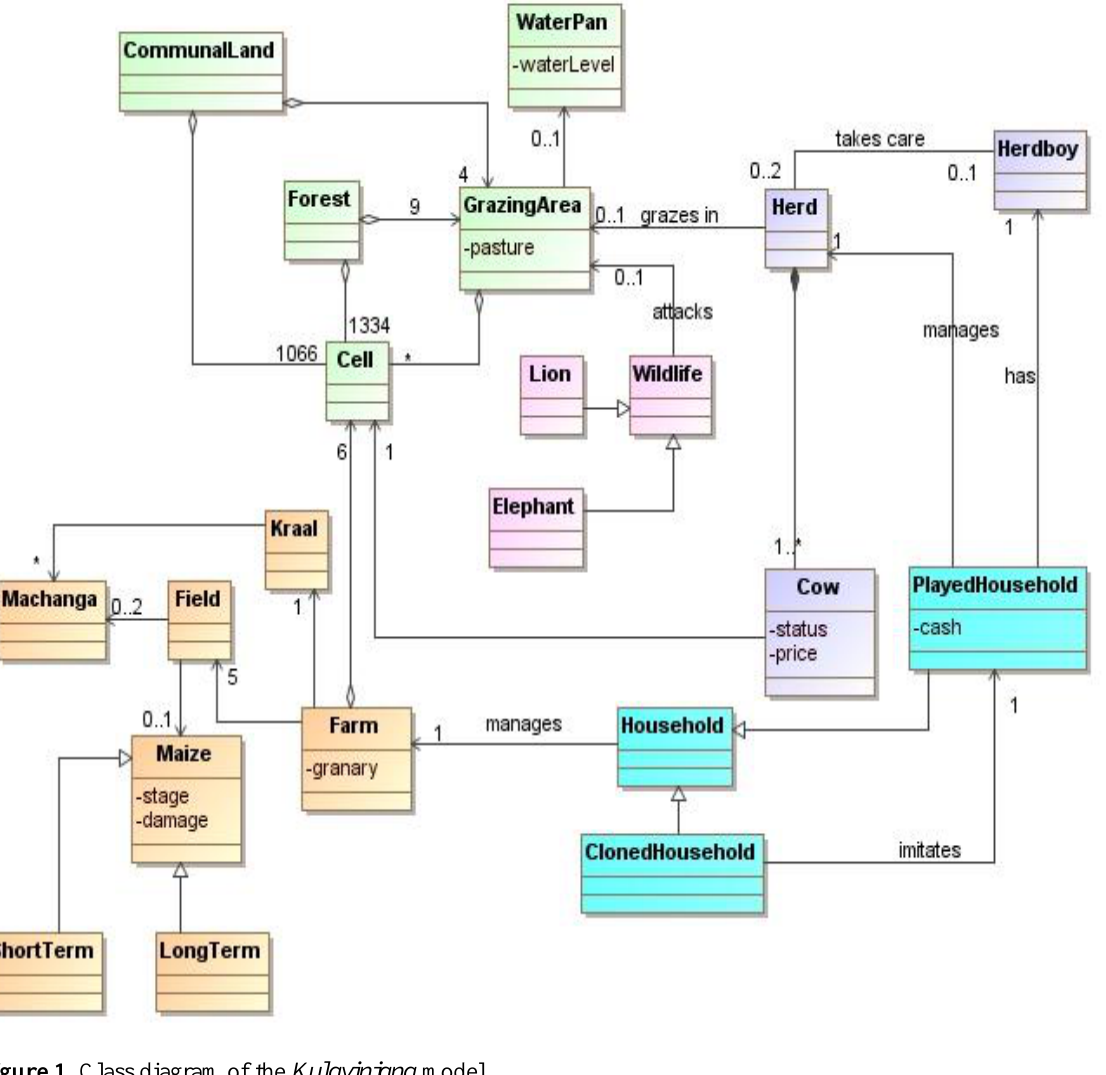
Figure 1. Class diagram of the Kulayinjana